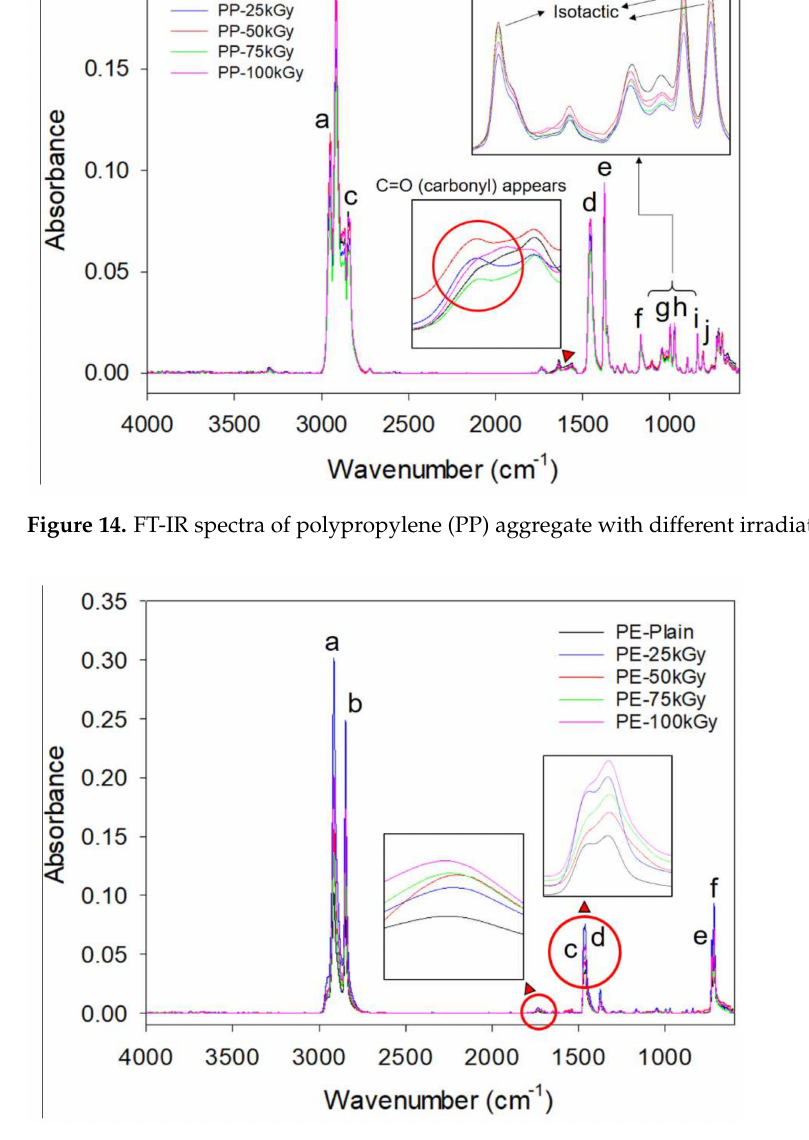
Figure 15. FT-IR spectra of polyethylene (PE) aggregate with different irradiation doses. As a result of the FT-IR analysis of the PP aggregate, from Figure 14, in the FT-IR spectrum of neat PP, the peaks observed near 1166 and 977 cm − 1 confirm that the PP used in the present case is isotactic. It is observed that the intensity of these peaks continuously decreases with the increase in gamma irradiation dose, and this indicates that these bonds are the result of chain scission by gamma radiation. Furthermore, new characteristic bands at 1650 cm − 1 appear at all the gamma dose levels. These correspond to the carbonyl C=O groups, and the appearance of the C=O group indicates oxidation. This is because the C-H and C-C bonds of PP are the result of scission and consequently the formation of free radicals and ionized species. The reaction of free radicals with oxygen does not allow the polymer chains to crosslink, which leads to chain scission predominating over crosslinking in